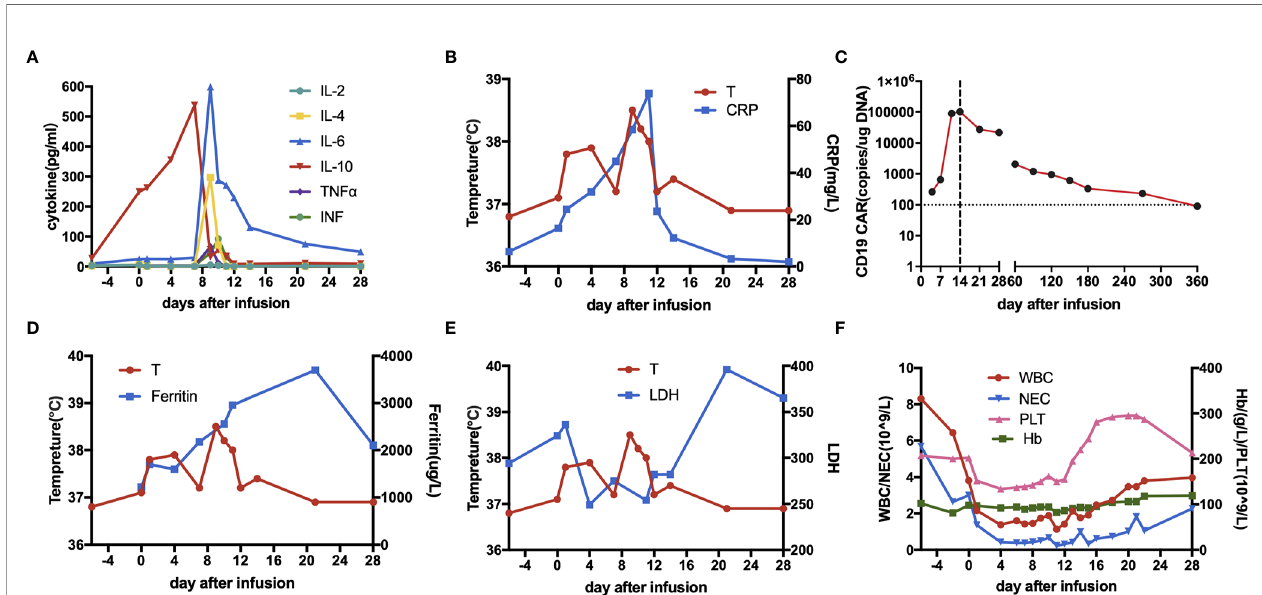
FIGURE 3 | Clinical monitoring after infusion of piggyBac-generated CAR19-T cells. (A) Trends of Interleukin(IL)-2, IL-4, IL-6, IL-10, tumor necrosis factor a (TNF a ) and interferon (INF) during 28 days after infusion. (B) Trend of C-reactive protein (CRP) was associated with temperature (T) rising during 28 days after infusion. (C) CAR19 copies in peripheral blood were measured by quantitative polymerase chain reaction. (D, E) The peak values of ferritin and lactate dehydrogenase (LHD) after infusion were later than temperature. (F) Changes of white blood cells (WBC), neutrophils (NEC), platelet (PLT) and hemoglobin (Hb) during 28 days after